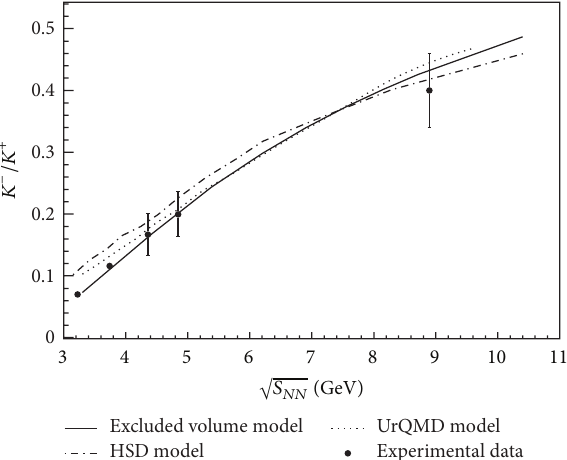
Figure 7: Variation of 𝑝/𝑝 with respect to √𝑠 𝑁𝑁 . Experimental data is taken from [30–35].